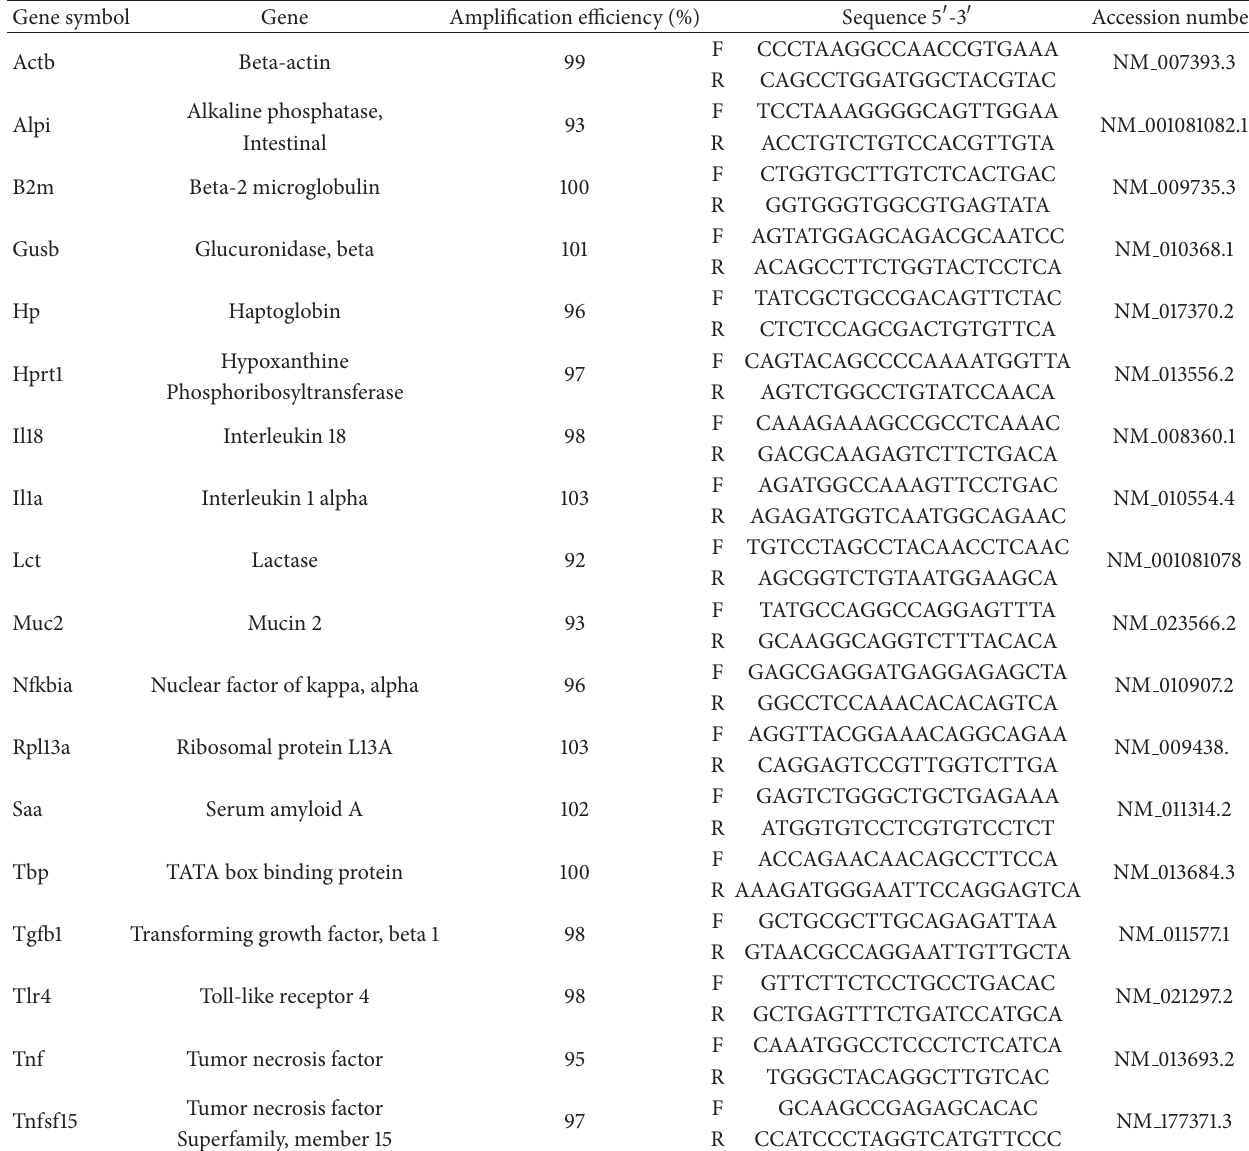
Table 2: Genes tested by qPCR in ileum tissue of in C57BL/6 mice treated or not treated with Ampicillin from birth to five weeks of age, from 12 to 16 weeks of age, or